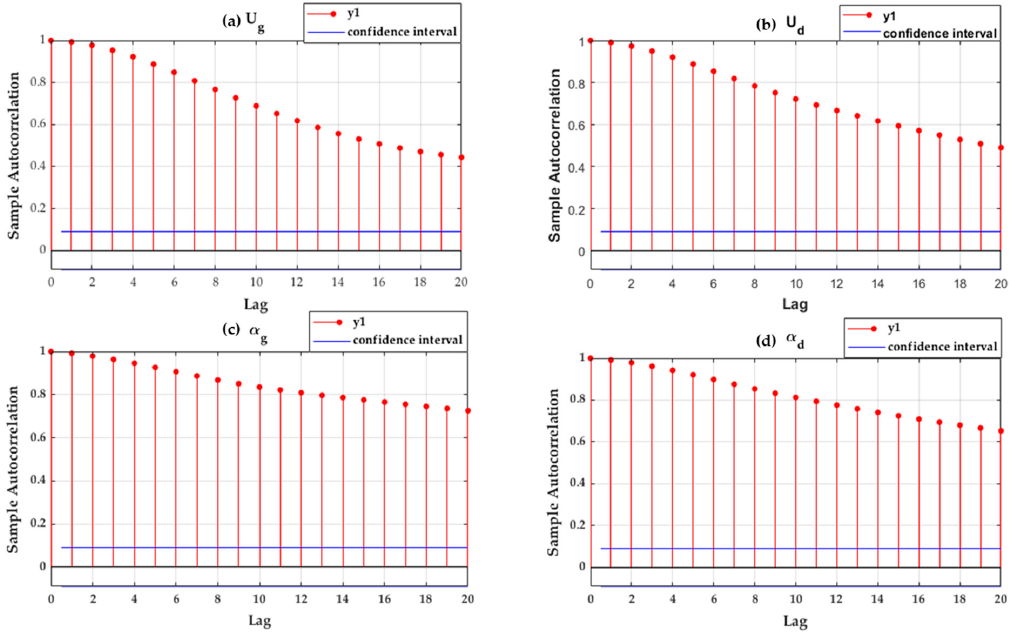
Figure 9. Autocorrelation function curves (ACF) of original time-series ( a ) U g ( b ) α g ( c ) U d ( d ) α d .